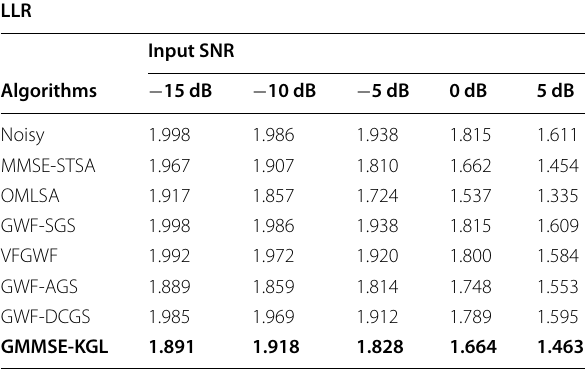
Table 8 The LLR of different methods for Gaussian color noise LLR